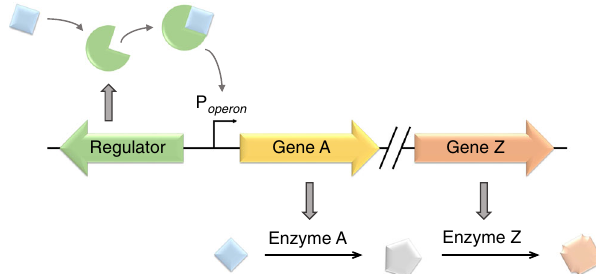
Fig. 1 Schematic illustration of a TR controlling expression of a metabolic cluster of genes. The primary substrate was proposed to be the ligand (light blue diamond). Note that the enzyme that converts the primary substrate into an intermediate product (grey regular pentagon) may be encoded by any of the genes in the operon. TR gene and protein are shown as green left arrow and pie, respectively. Metabolic cluster genes are yellow and orange right arrows. Product of metabolic conversion is shown as an orange